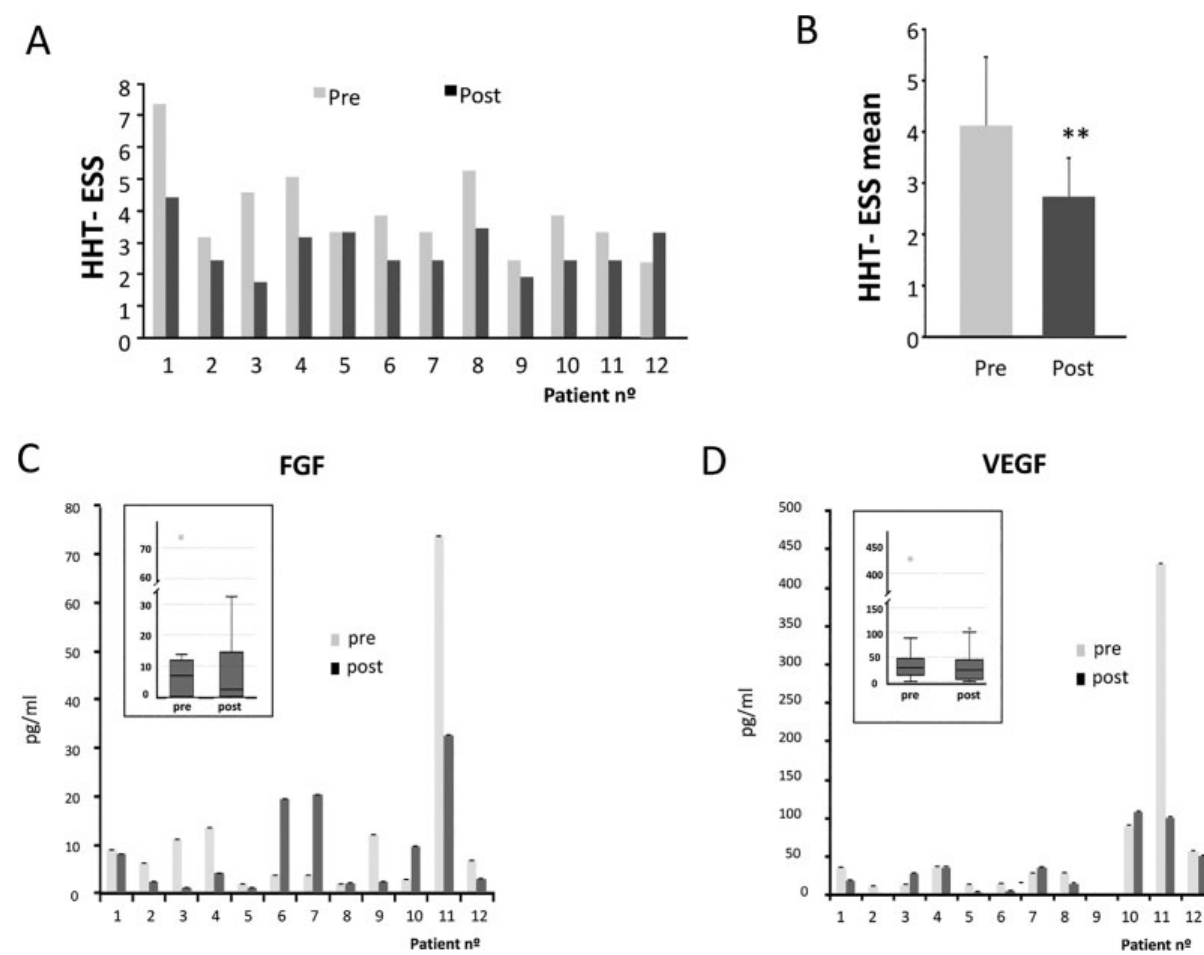
Fig. 7 Levels of epistaxis severity score (ESS). ( A ) HHT-ESS of the 12 patients before and after the treatment. ( B ) HHT-ESS mean of pre- and posttreatment levels of the patients. A Student ’ s t -test was made to compare pre- and posttreatment HHT-ESS values. Differences were signi fi cant at p < 0.01. ( C and D ) Analysis of FGF and VEGF, as biomarkers related to angiogenesis and bleeding. The graph shows pre- and posttreatment results. FGF, fi broblast growth factor; HHT, hereditary hemorrhagic telangiectasia; VEGF, vascular endothelial growth